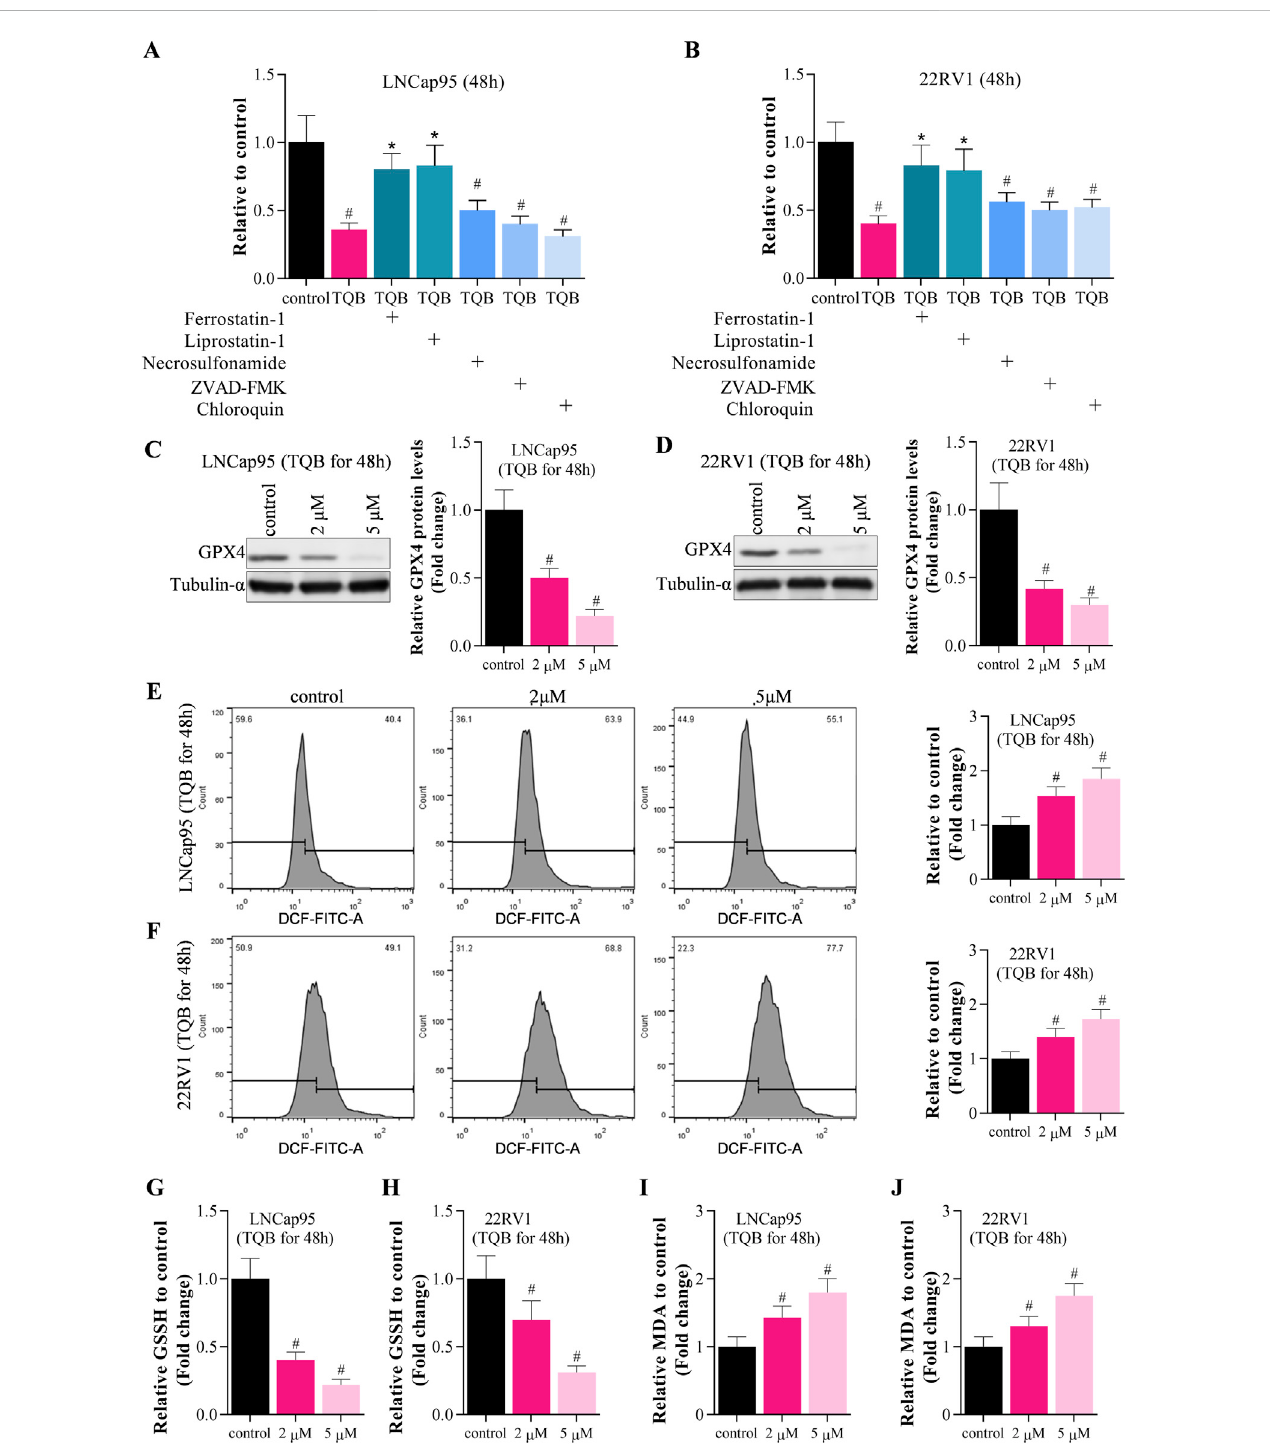
FIGURE 2 TQB3720 induced ferroptosis of prostate cancer cells. (A,B) The proliferation of LNCap95 and 22RV1 cells signi fi cantly decreased following TQB3720 incubation for 48 h, whereas ferrostatin-1 and liprostatin-1 abolished this effect, # p < 0.01 vs. control, * p < 0.01 vs. TQB3720 (5 μ M) (C,D) Western blot showed effects of TQB3720 on expression of ferroptosis marker GPX4, # p < 0.01 vs. control. (E,F) Flow cytometry assay showed the effects of TQB3720 onROS levels using DCFH-DA probes, # p < 0.01 vs. control. (G,H) ELISA results showed theeffectsof TQB3720on GSSG levels incancer